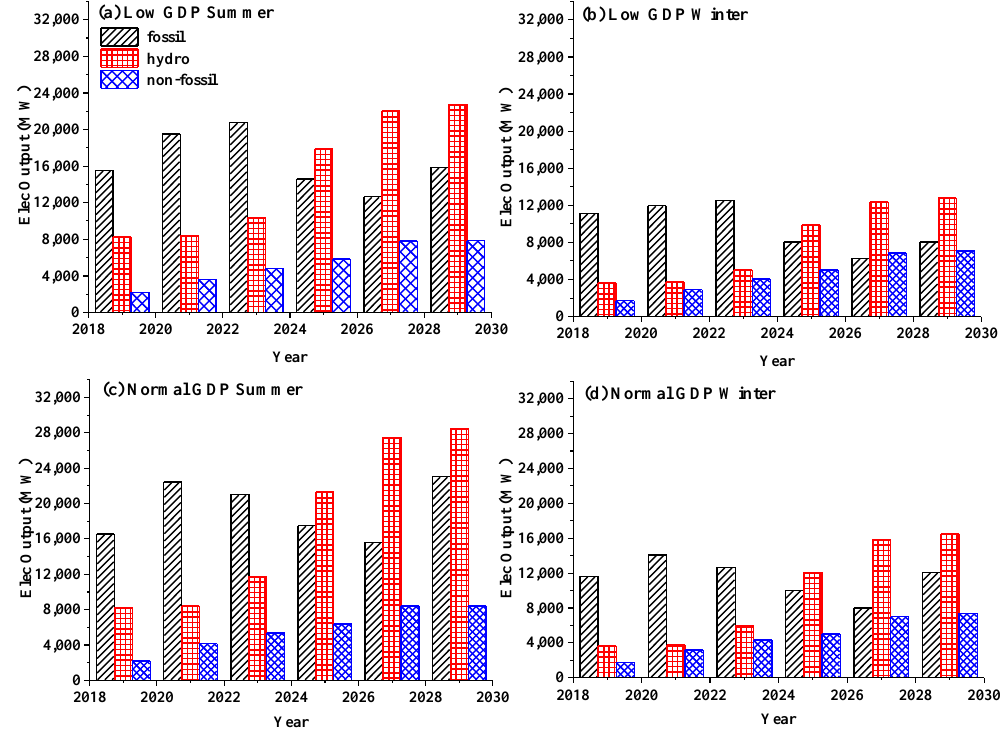
Figure 13. Optimal energy mix under the CCS case.